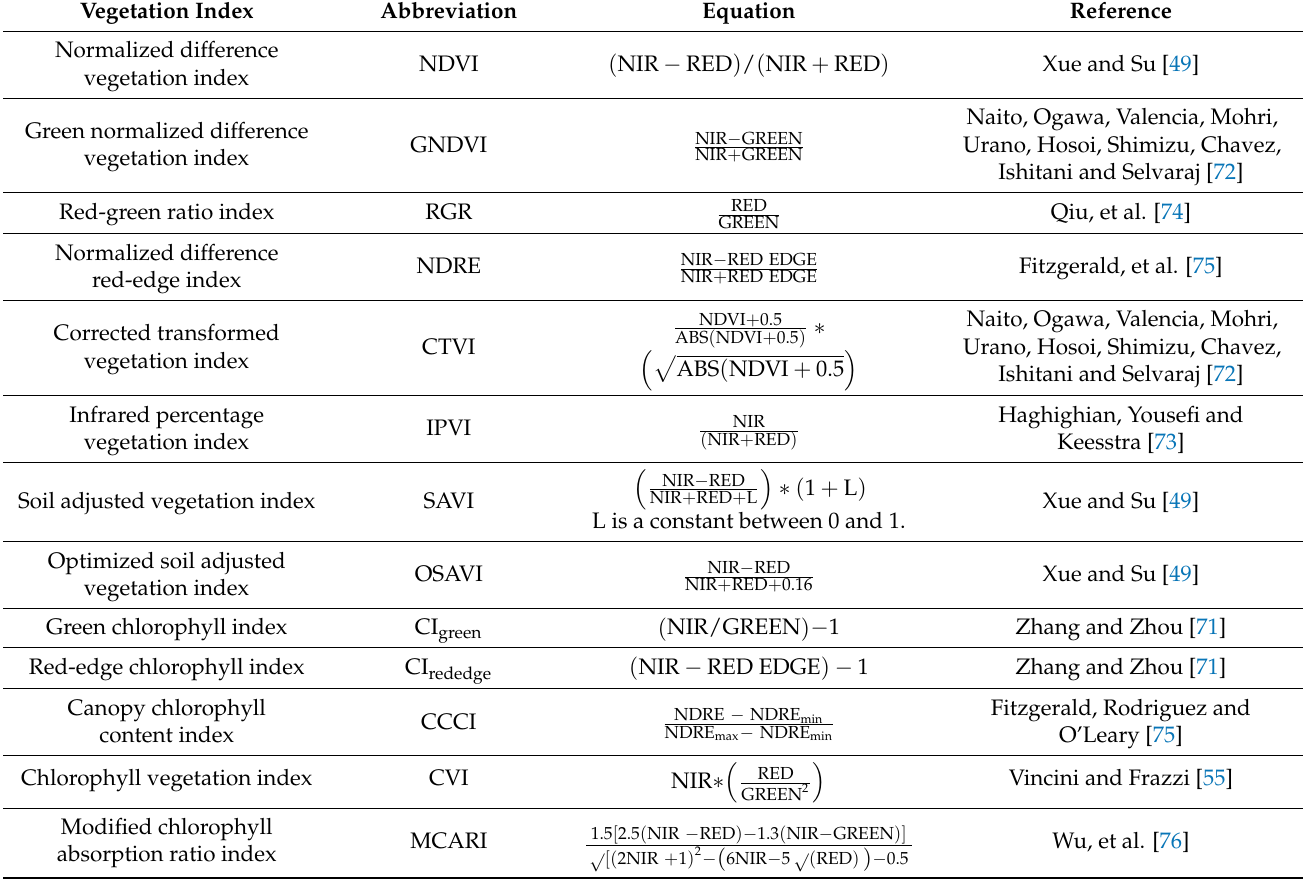
Table 4. UAV-derived vegetation